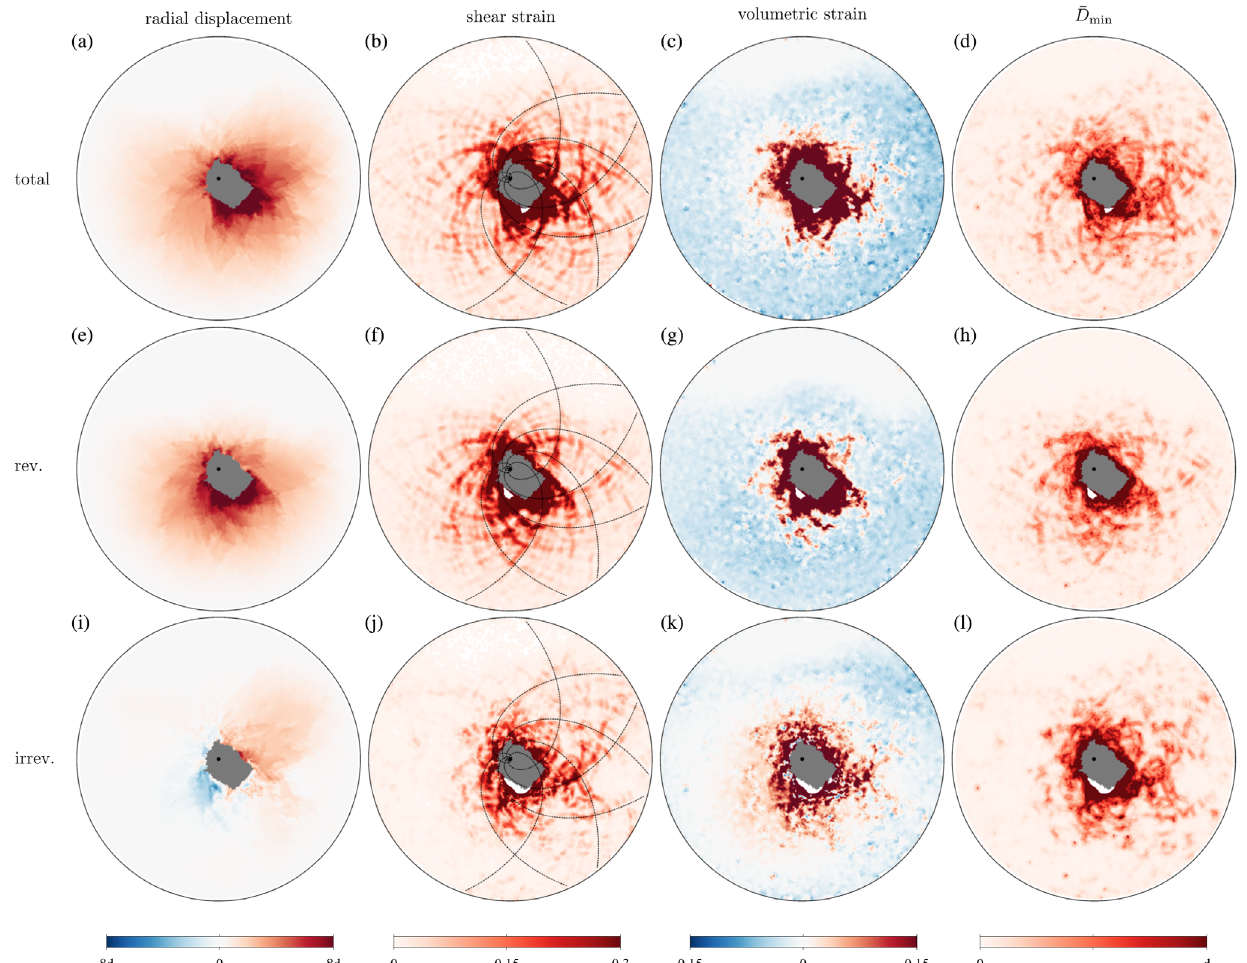
FIG. 3. The displacement field is characterized by a petal-like mesoscale structure that corresponds to spiral bands in the shear strain field. Here we show (a) the radial displacement, which reveals detailed mesoscale structure reminiscent of flower petals. We show (b) the magnitude of the shear strain with several logarithmic spirals for comparison (dashed black curves). The spirals have a pitch of π = 4 , which is consistent with the shear failure of a material with negligible shear strength. We also show (c) the volumetric strain, which shows expansion in the inner region and compression in the outer region, and is relatively axisymmetric. Lastly, we include (d) the ¯ D typical nonaffine displacement (see Appendix A). The nonaffine displacement is much smaller than the radial displacement min except near the cavity, where the kinematics become strongly nonaffine. The strain field is not necessarily a good measure of the deformation in areas with large amounts of nonaffinity (near the cavity). We plot these quantities from an Eulerian perspective (against current radial position r ). We decompose the deformation field into (e) – (h) reversible and (i) – (l) irreversible components. For comparison, we project all fields onto the deformed configuration at steady state. The reversible component is larger in magnitude than the irreversible component and contains most of the mesoscale structure. The irreversible component contains much of the nonaffine